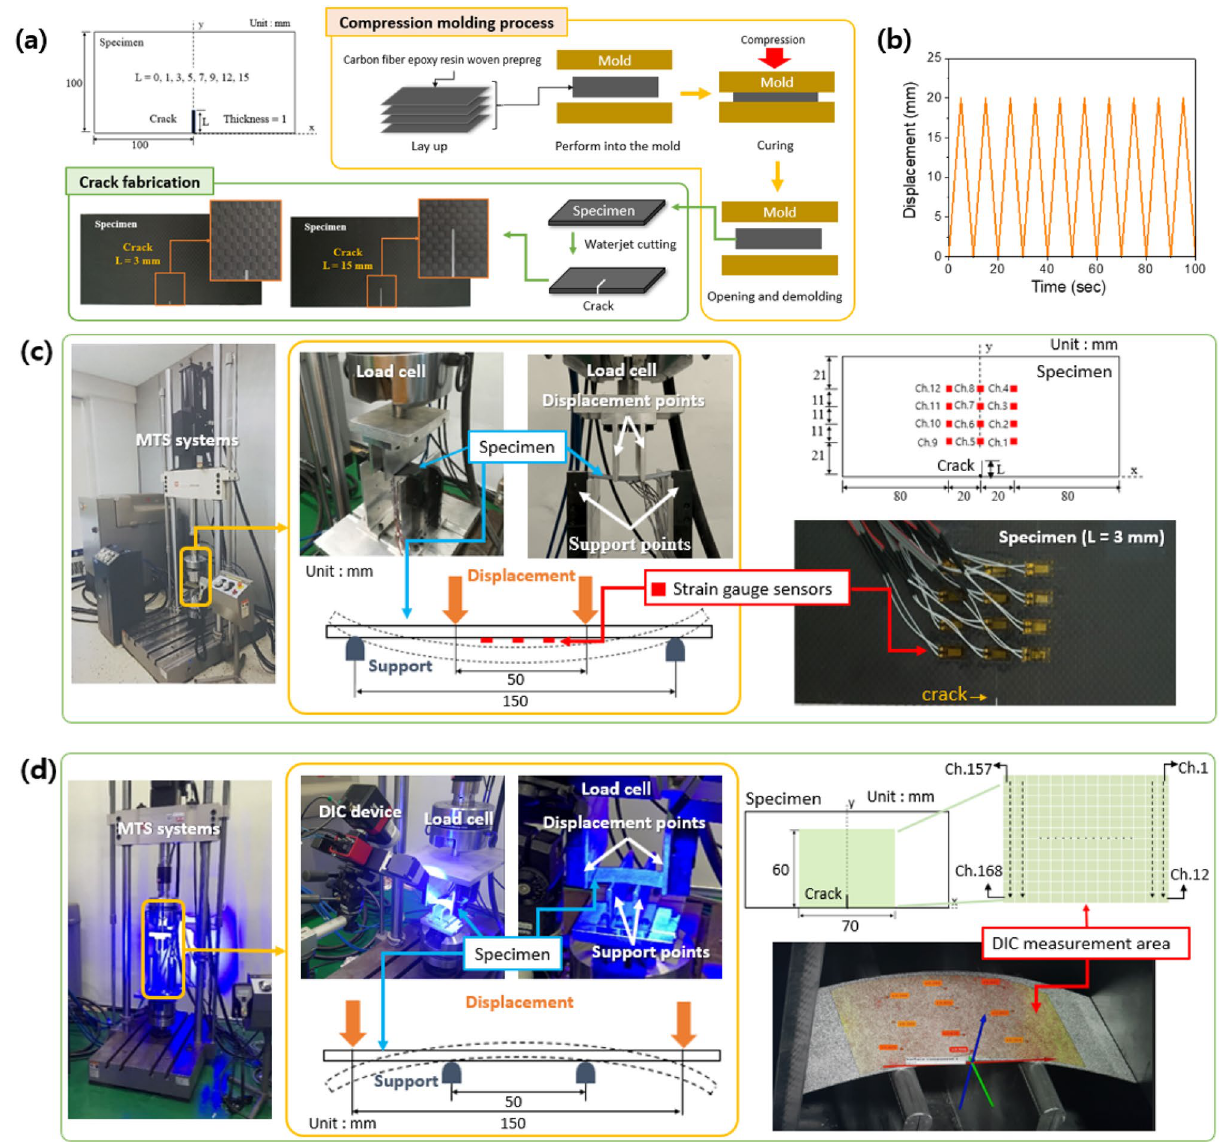
Figure 2. Experimental setup ( a ) Schematic of the specimen geometry and preparing process of the specimens, ( b ) Cyclic 4-point bending, ( c ) strain measured with strain gauge sensors, ( d ) strain field measured with DIC